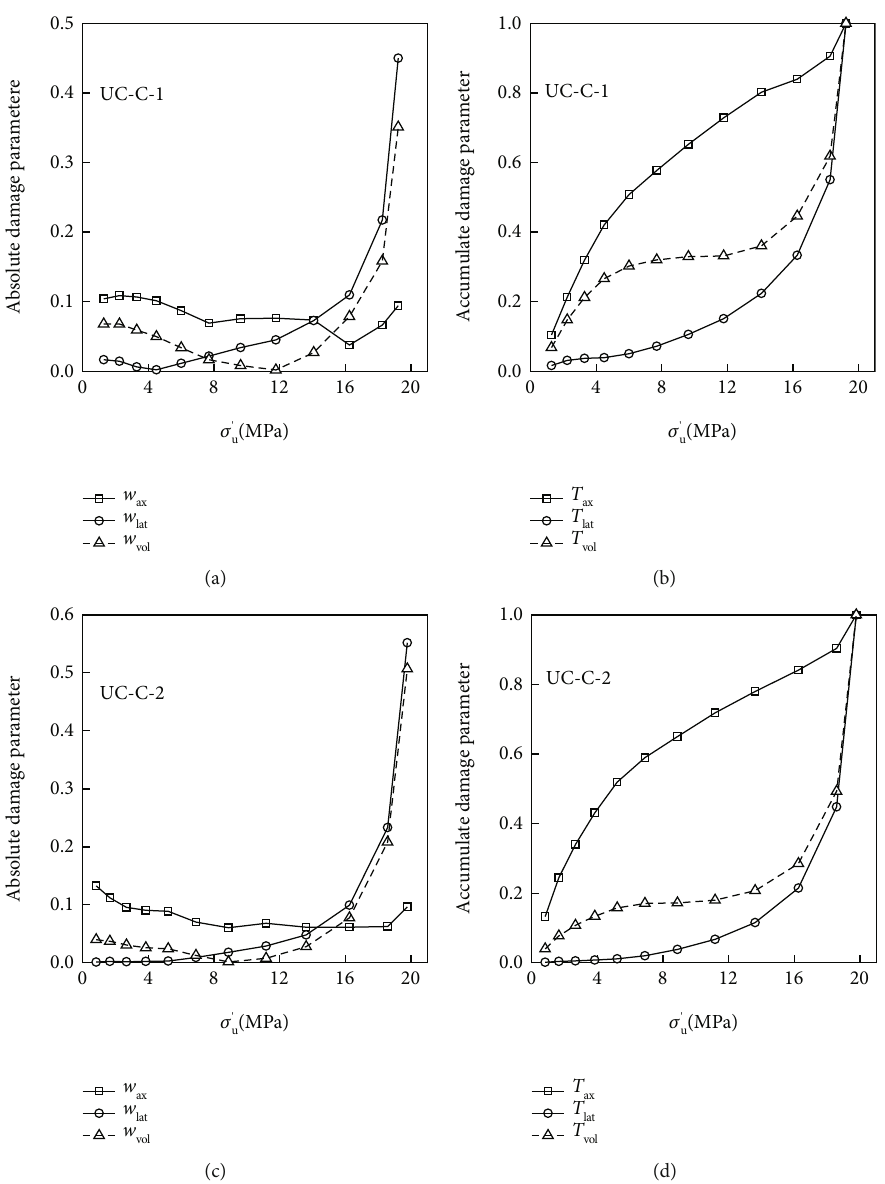
Figure 8: Damage parameters of sandstone with di ff erent unloading stress levels: (a) absolute damage parameter of UC-C-1; (b) accumulated damage parameter of UC-C-1; (c) absolute damage parameters of UC-C-2; (d) accumulated damage parameters of